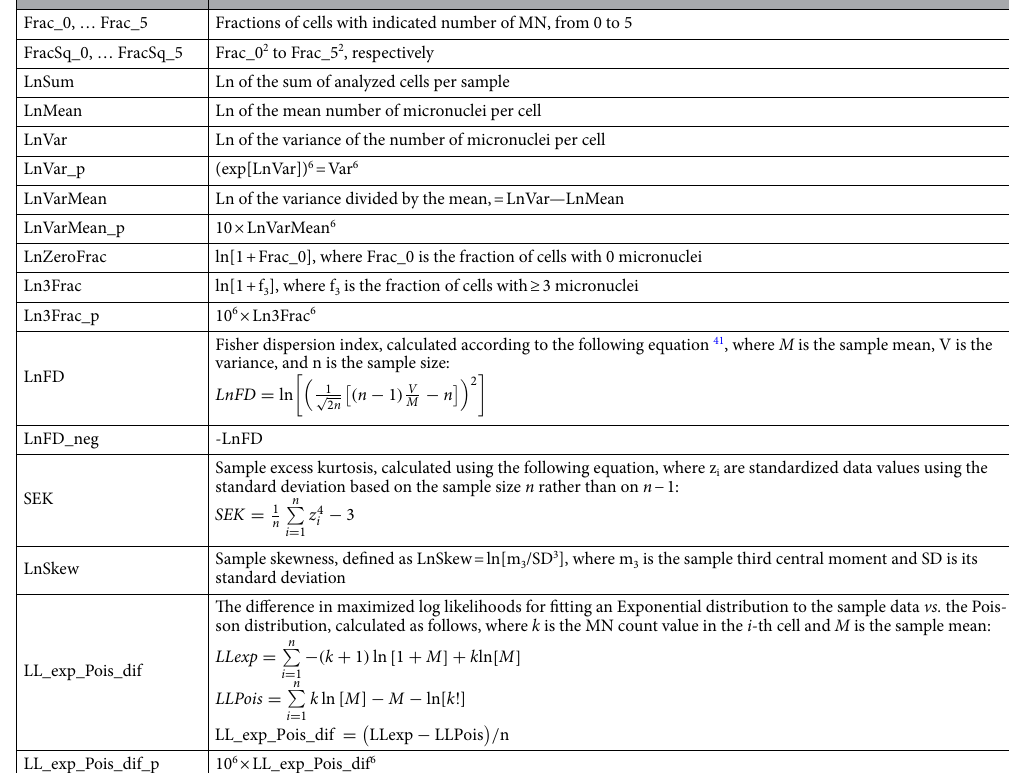
The difference in maximized log likelihoods for fitting an Exponential distribution to the sample data vs. the Pois- son distribution, calculated as follows, where k is the MN count value in the i -th cell and M is the sample mean: n ( k 1 ) ln[1 M ] k ln[ M LLexp − + + + = (cid:31) i = 1